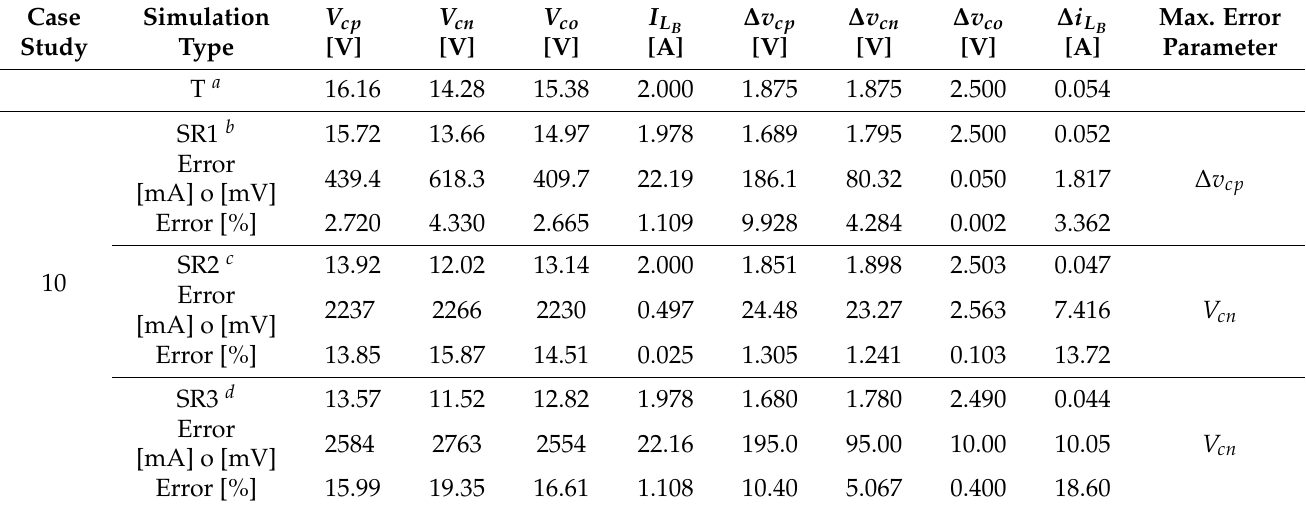
Table 10. Theoretical and simulated with real approximation of